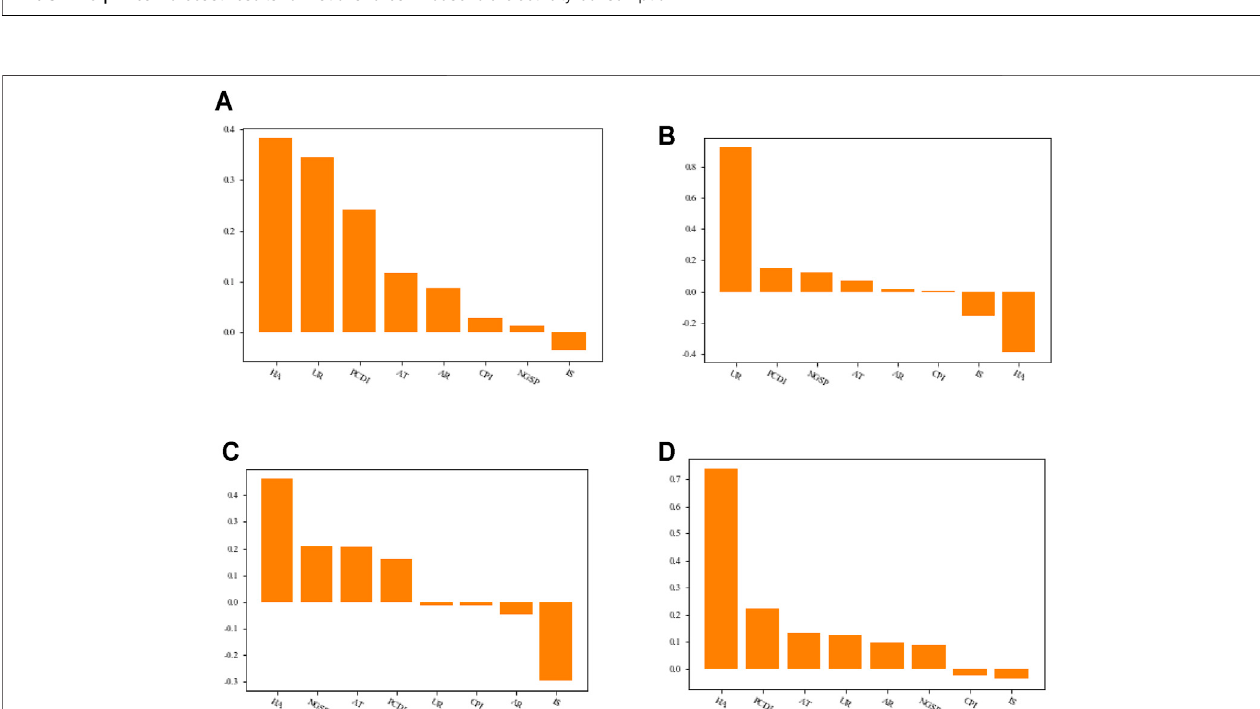
FIGURE 4 | Ranking the importance of linear predictor variables of electricity consumption in urban households across the country.